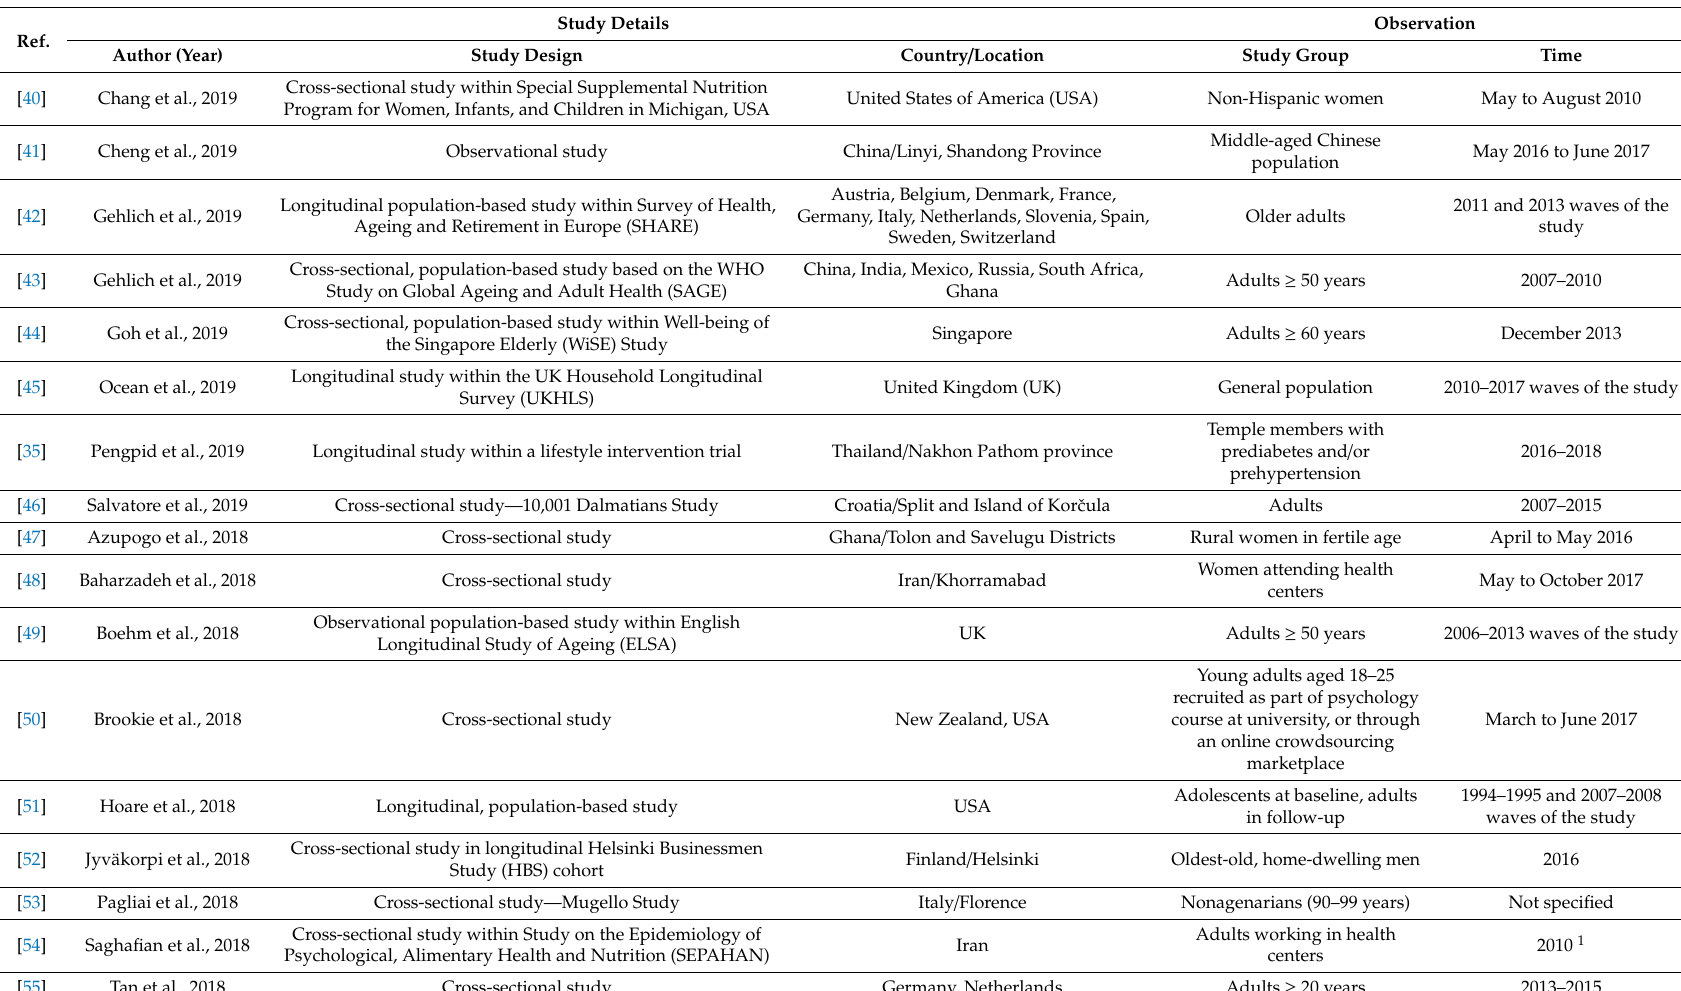
Table 1. General details of the study and design for the studies included to the systematic